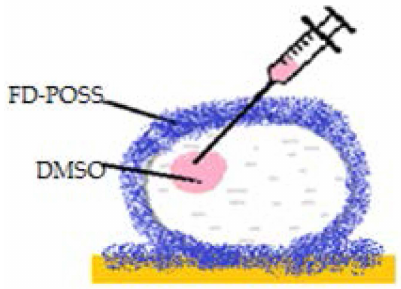
Figure 8. Liquid marble made from hexadecane/toluene, covered by FD-POSS, encapsulating DMSO.